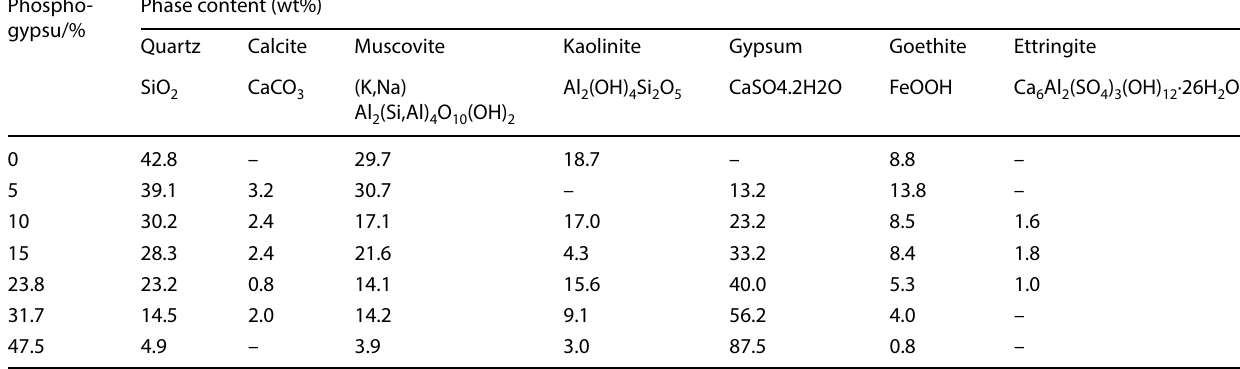
Table 10 Quantitative analysis of mineral composition of mixture Phospho- Phase content (wt%) gypsu/%